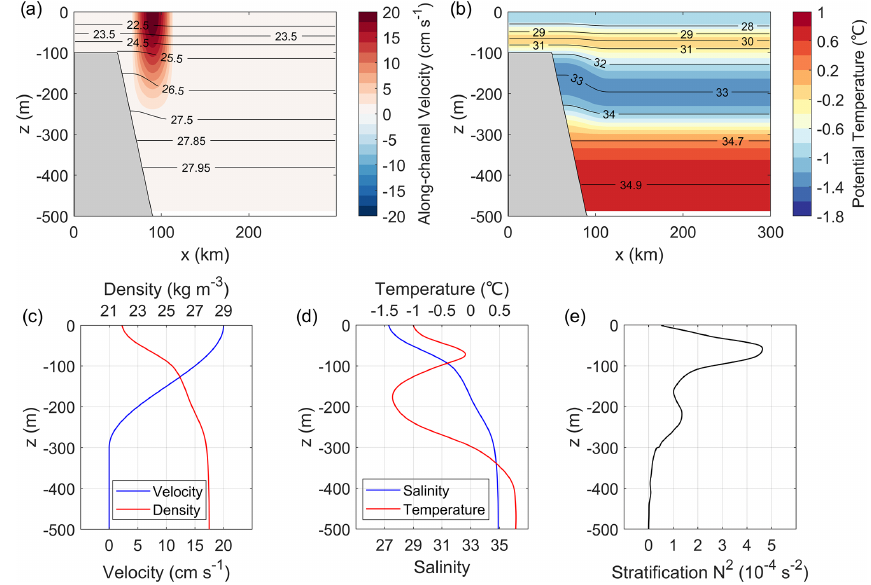
Figure 3. Initial conditions for the numerical experiments: (a) along-channel velocity (color) and isopycnals (black contours), (b) potential temperature (color) and isohalines (black contours), (c) vertical profiles of the along-channel velocity (blue) and density (red) at the flow center ( x = 90km), (d) vertical profiles of the salinity (blue) and temperature (red) at x = 90km, and (e) vertical profile of the background mean stratification N 2